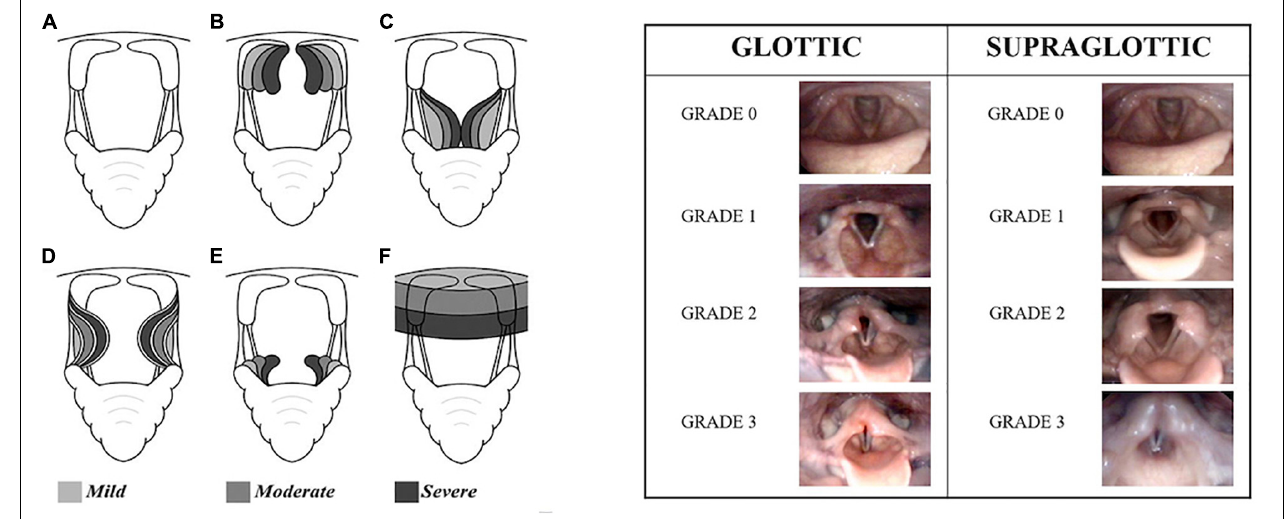
FIGURE 1 | (Left) The equine grading system. Schematic illustration of (A) normal larynx, (B) arytenoid cartilage collapse, (C) vocal fold collapse, (D) medial deviation of aryepiglottic folds, (E) collapse of margins of epiglottis, and (F) pharyngeal roof collapse. Light gray: mild, gray: moderate, and dark gray: marked. With permission from K. Olstad. (Right) The human grading system according to Maat et al. (2009) illustrated by endoscopic photographic images during exercise from the larynx showing the different grades of laryngeal obstruction at the glottic and supraglottic